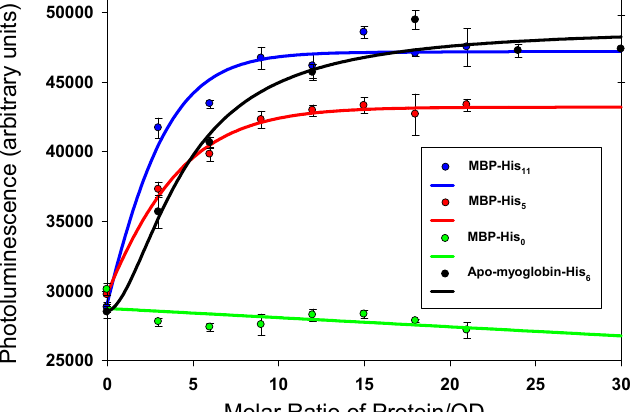
Figure 3. Quantum Dot – Protein Interactions. Comparison of the ability of several proteins to increase QD photoluminescence upon interacting with the QD surface. In this case, polyhistidine ) expressing proteins self-assemble onto the QDs via metal affinity coordination [40,54]. Three (His n maltose binding protein (MBP) variants expressing either 0, 5 or 11 C-terminal histidines and apo- myoglobin expressing a C-terminal 6-histidine tract were allowed to coordinate to the QDs at the indicated molar ratios. Changes in QD PL were then assayed fluorometrically and compared to the 0- ratio control. Note the MBP lacking a histidine-tract does not produce a PL